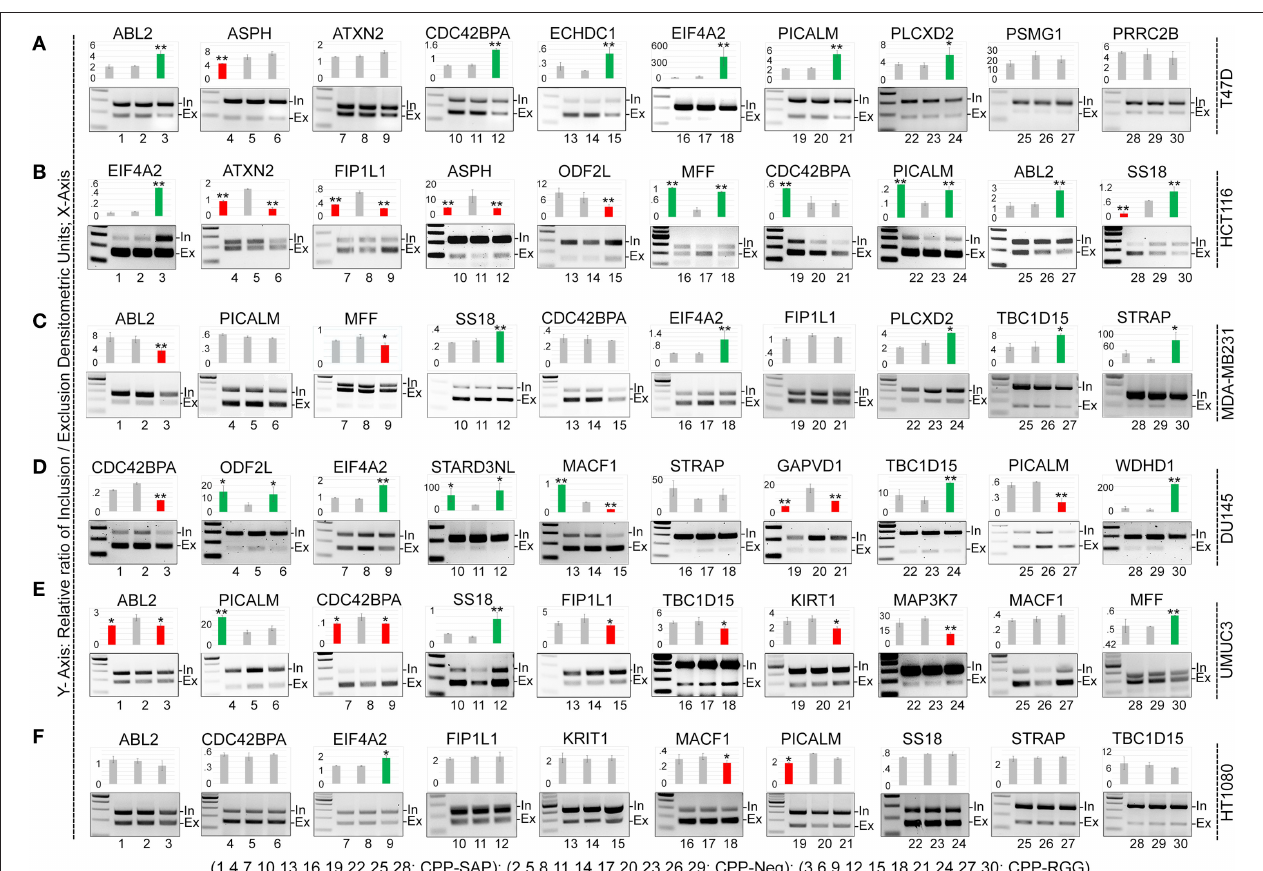
FIGURE 3 | CPP-RGG and CPP-SAP dysregulate alternative splicing of SAFA-targets in vivo in wide range of cells. (A–F) RT-PCR testing of known SAFA-dependent splicing targets in T47D (A) , HCT116 (B) , MDA-MB231 (C) , DU145 (D) , UMUC3 (E) , and HT1080 (F) cells treated with CPP-Neg, CPP-SAP, and CPP-RGG peptides for 12h. Bar graph indicates the relative ratio of cassette inclusion to exclusion as determined by densitometry. Red and green bars indicate exclusion and inclusion, respectively. Representative gel pictures are shown below the bar graphs. * p < 0.05, ** p < 0.01 relative to